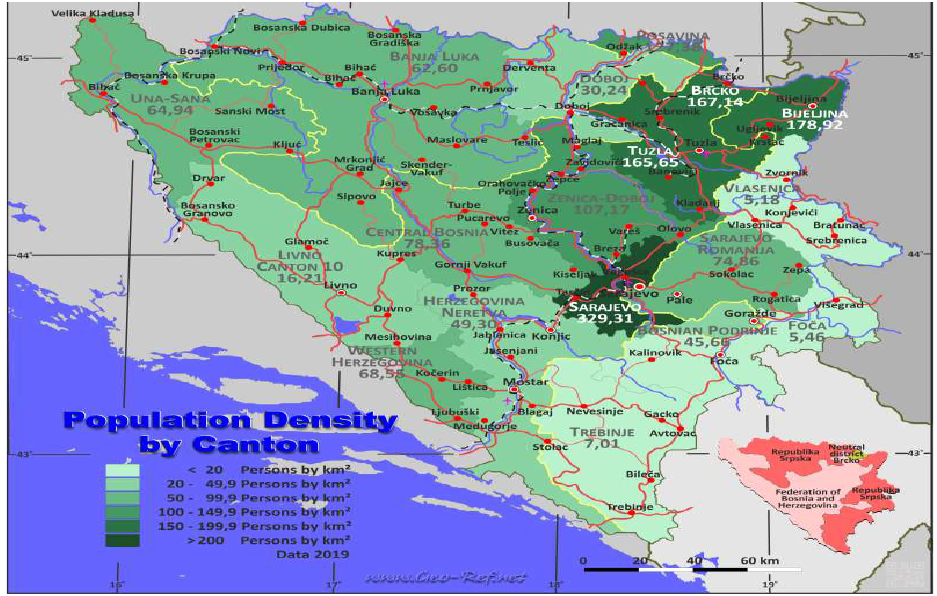
Figure 5. Population density and maps of B and H.